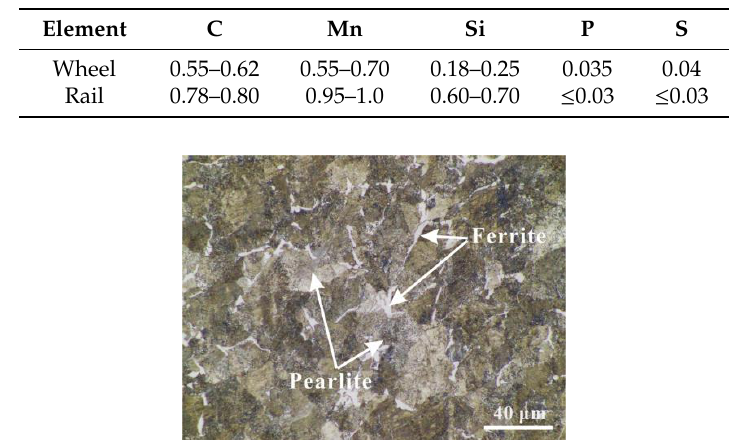
Figure 1. Sampling position ( a ) and scheme of geometrical contact ( b ) for the wheel and rail specimens. Table 1. Chemical composition of wheel / rail rollers (wt%).